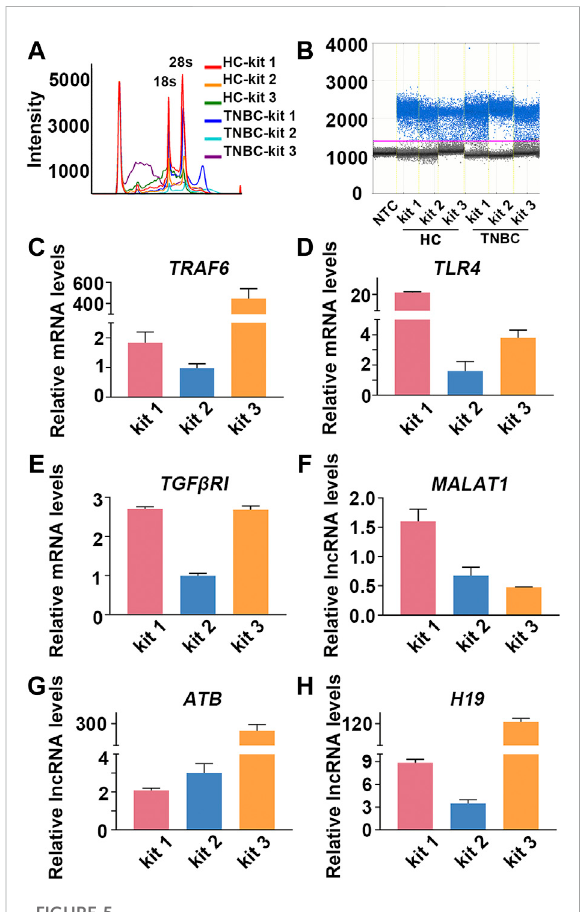
Compromised RNA results in skewed mRNA and lncRNA readouts in TNBC patient. (A) Representative image of RNA analysisbyanAgilentbioanalyzerineachgroup. (B) Representative one-dimensional plots of droplets measured for fl uorescencesignalemittedfrom β -actinineachgroup. (C – H) The relative transcriptional readouts of the informative mRNAs and lncRNAs in TNBC patient in each group.